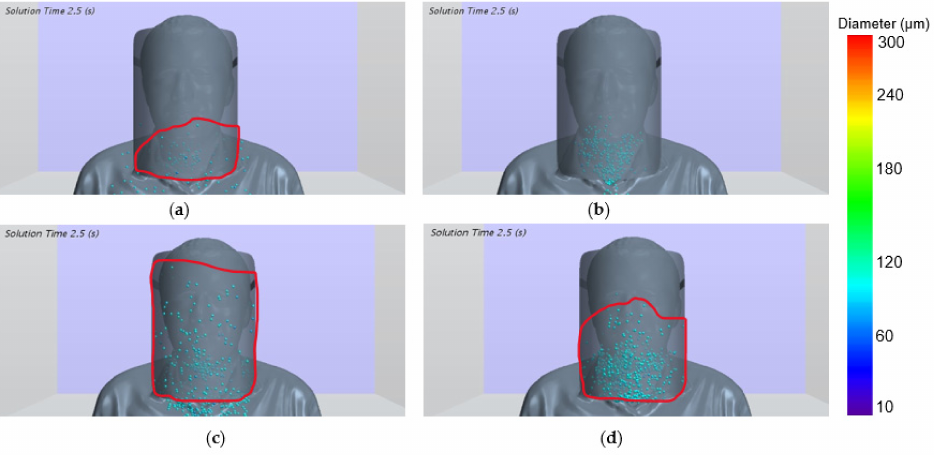
Figure 10. Area of the face shield that protects the human at a 40% RH and T e = 25 ◦ C. ( a ) Wind speed of 7 km/h and the mouths at the same height; ( b ) Wind speed of 14 km/h and the mouths at the same height; ( c ) Wind speed of 7 km/h and the mouths with a height difference of 20 cm; ( d ) Wind speed of 14 km/h and the mouths with a height difference of 20 cm.